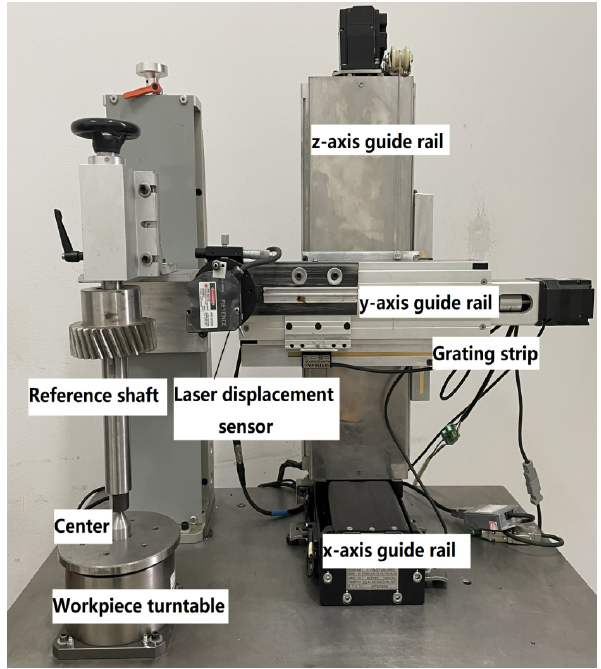
Figure 7. Physical drawing of the laser measuring platform.